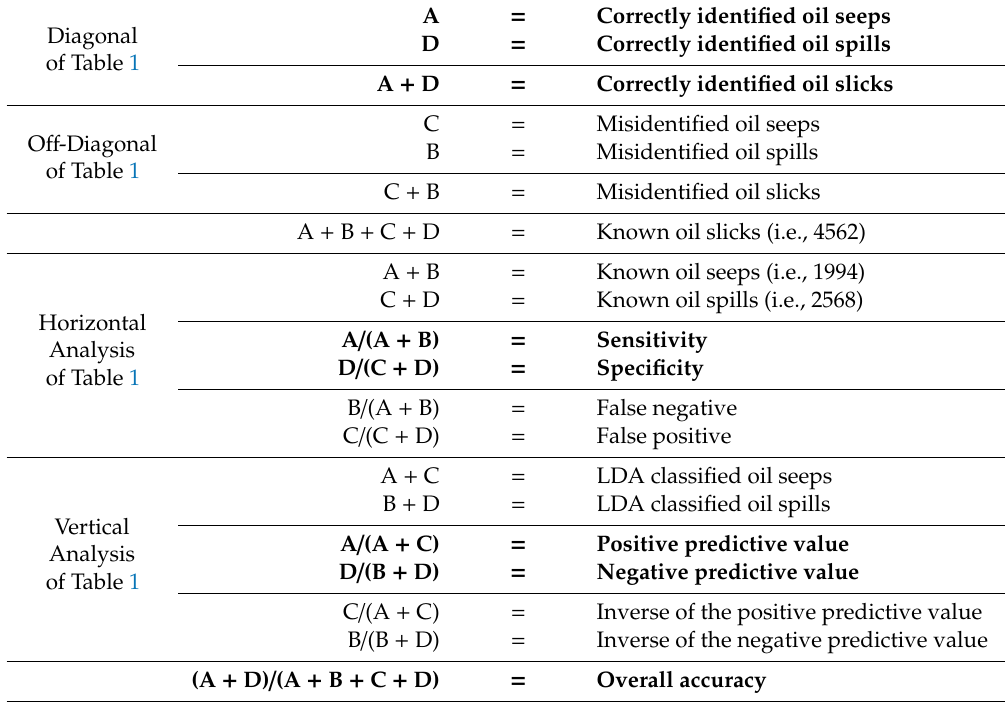
Table 2. List of statistical standard metrics associated with the confusion matrix [75–77]. See Table 1 for A, B, C, and D. Bold indicates relevant metrics explored herein—refer to Table